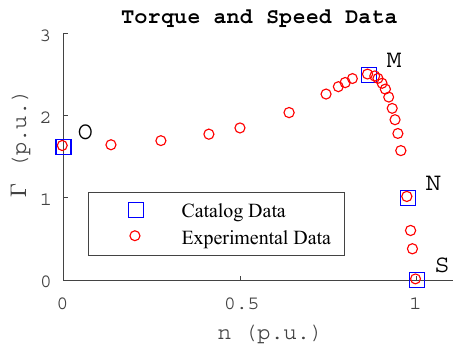
Figure 3. Reference data. Manufacturer data (blue) and experimental torque–speed curve (red).